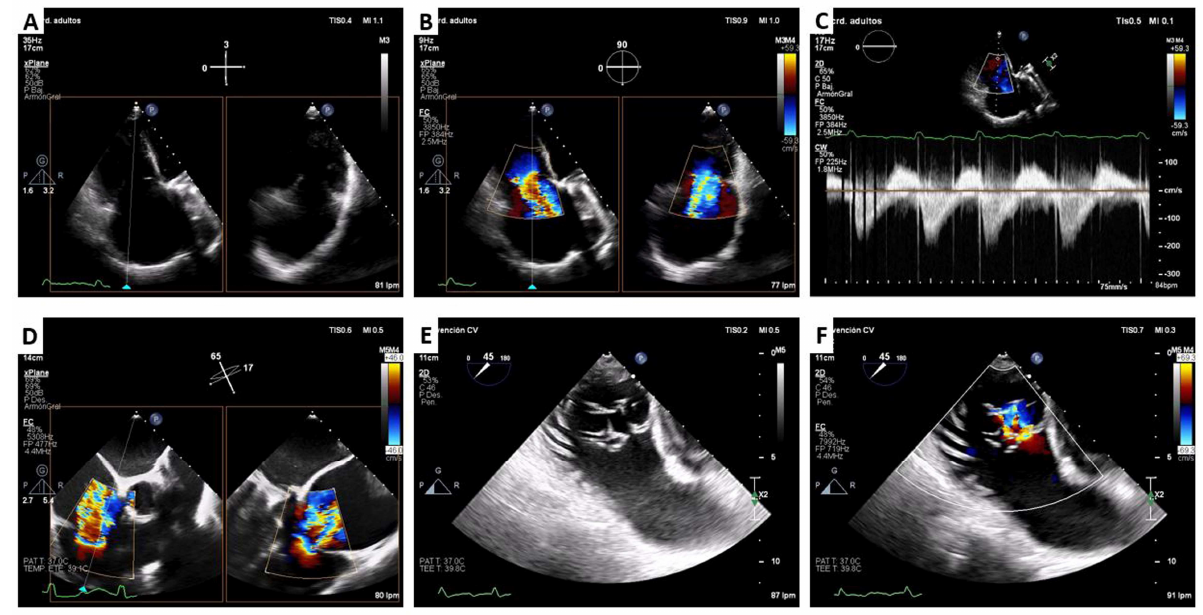
Figure 2. Cardiovalve TTVR case. Pre-procedural transthoracic and transesophageal echocardio- graphy. Massive tricuspid regurgitation: central valve coaptation gap ( A , E ), wide vena contracta regurgitation jet ( B , D , F ), and triangular dense continuous doppler trace ( C ).